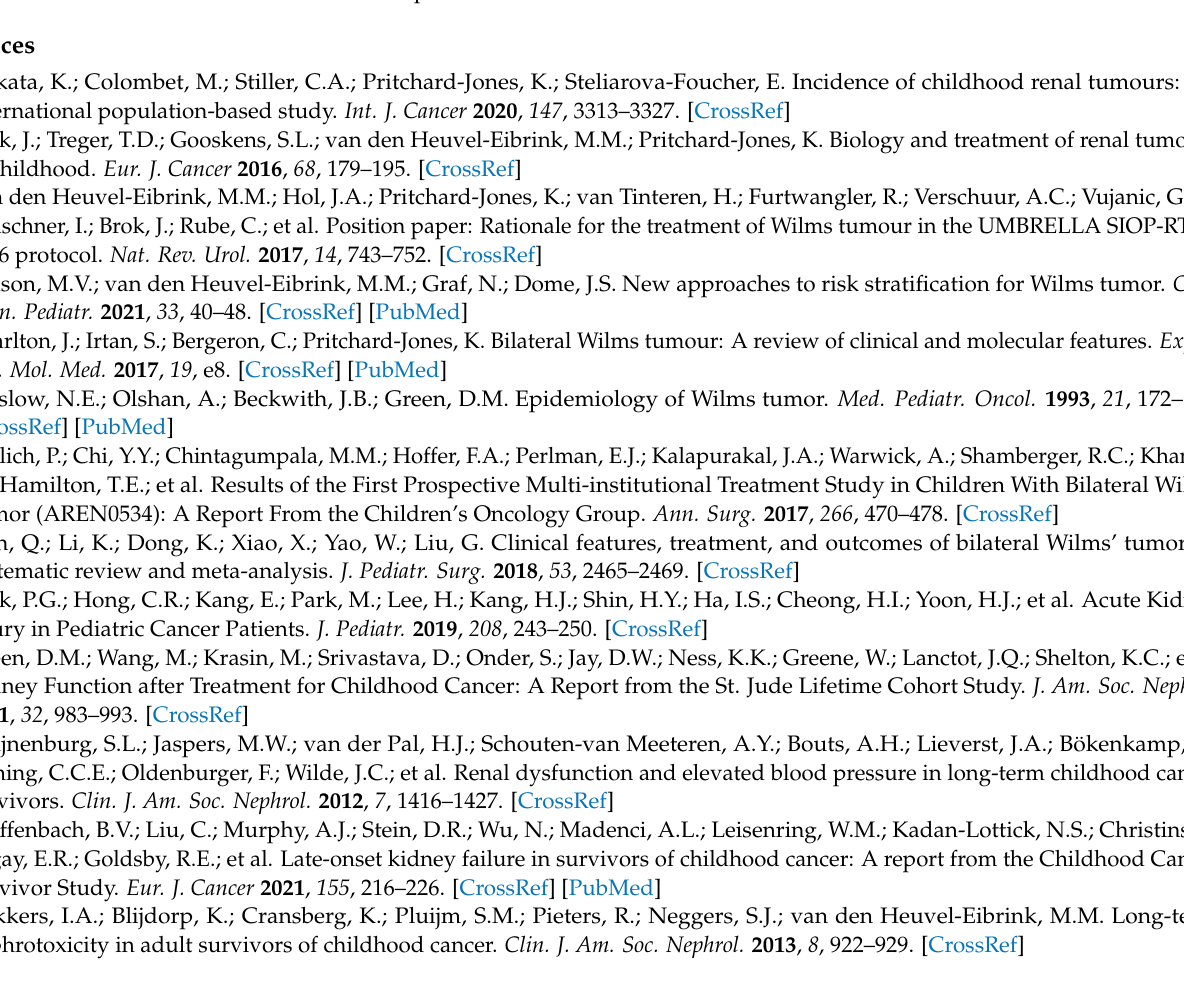
bilateral renal tumors., Figure S1: PRISMA flow diagram of article selection, Table S3: Presenting symptoms, Table S4: Stage V renal tumor patients with metastatic